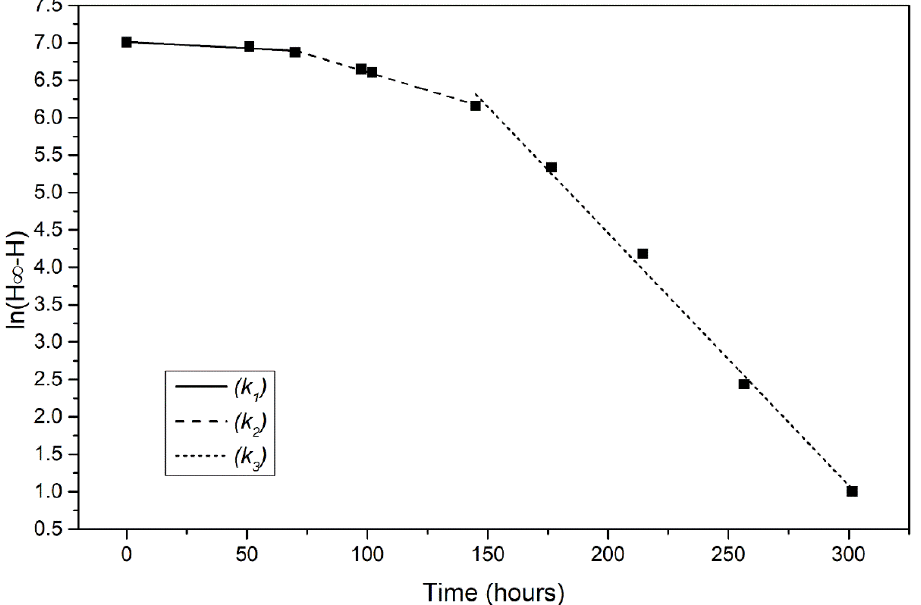
Figure 3. Representative plot of ln( H ∞ – H ) vs. time for fermentation at 18 °C by wild type strain W303-1a. The slope of each of the three lines represents the reaction rate constants k 1 , k 2 and k 3 of the three fermentation phases.